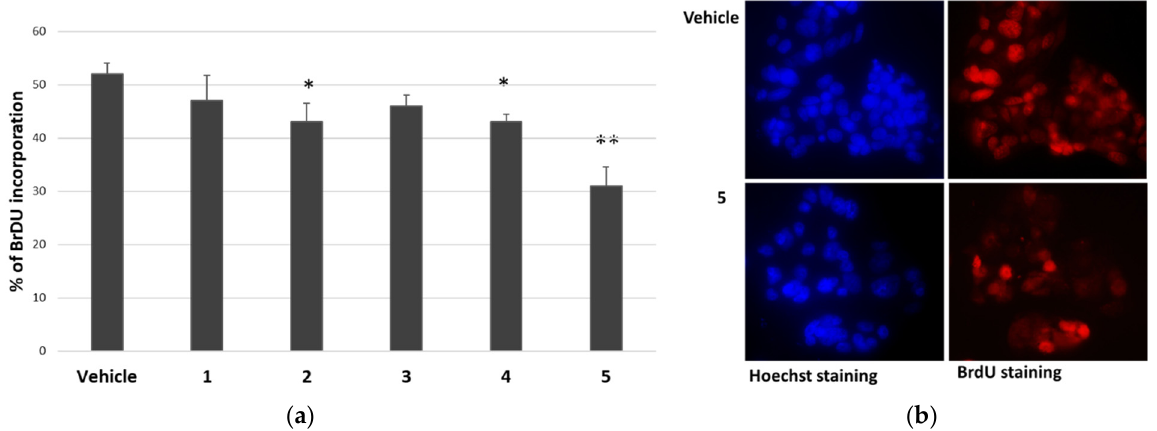
Figure 3. Effect of P. tomentosa compounds on BrdU incorporation in HepG2 cells. ( a ) Quantification of BrdU incorporation by cells cultured for 24 h in the presence of 1 μ M of each compound. Data are reported as mean ± SE of three experiments. Statistical analysis was performed using the Student’s t -test. * p < 0.05, ** p < 0.01 vs. vehicle-treated cells. ( b ) Microscopic visualisation of representative Hoechst-stained (blue) and BrdU-stained (red) nuclei of cells treated with the vehicle or compound 5 (magnification 40×, with oil).